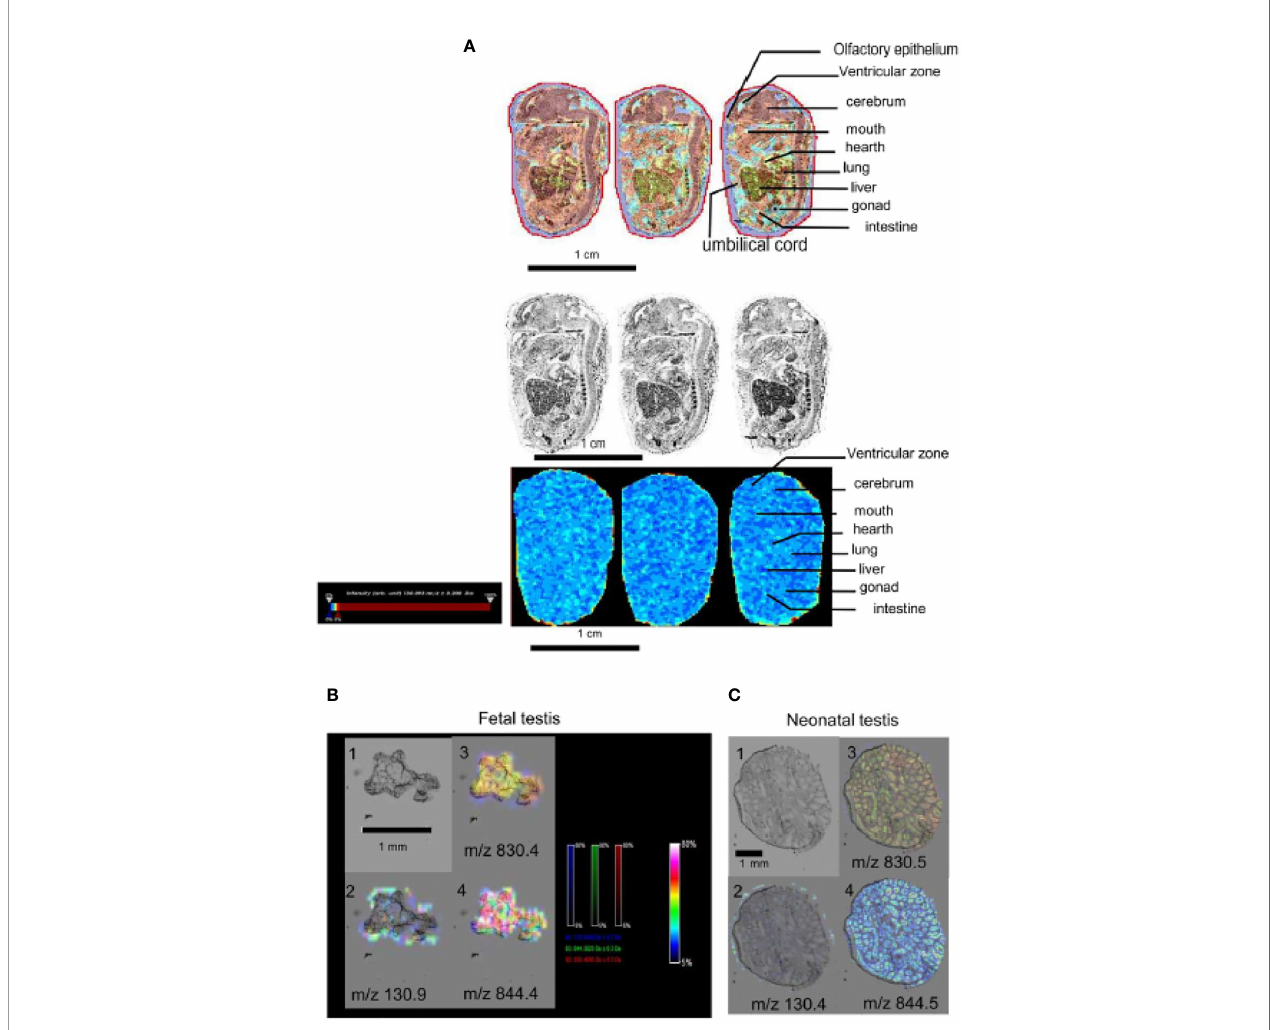
FIGURE 2 | Detection of metformin in embryo by selected ion monitoring (SIM) mass spectrometry (MS). (A) Upper panel, picture with brightness and arti fi cial color of sagittal section of a mouse embryo (15dpc) from a metformin-treated mother. Lower panel, MS imaging of metformin signal (m/z 130.1), images acquired at 30 m m spatial resolution. Intensity bar to the left of the picture. Scale bar 1 cm. (B) Embryonic testis (15dpc) and (C) neonatal testis (1dpp) exposed to metformin in utero . Panel 1: picture with brightness. Panel 2 pictures showing metformin signal (m/z 130.1). Panel 3 and 4 pictures showing positive signal (lipids) (m/z 830.4 and 844.4). Intensity values are expressed in arbitrary units (a.u.) normalized against the total ion count (low intensity: blue staining, high intensity: red staining), the intensity bar is in the middle of the image panel. We can note an absence of metformin on the testis. Scale bar 1